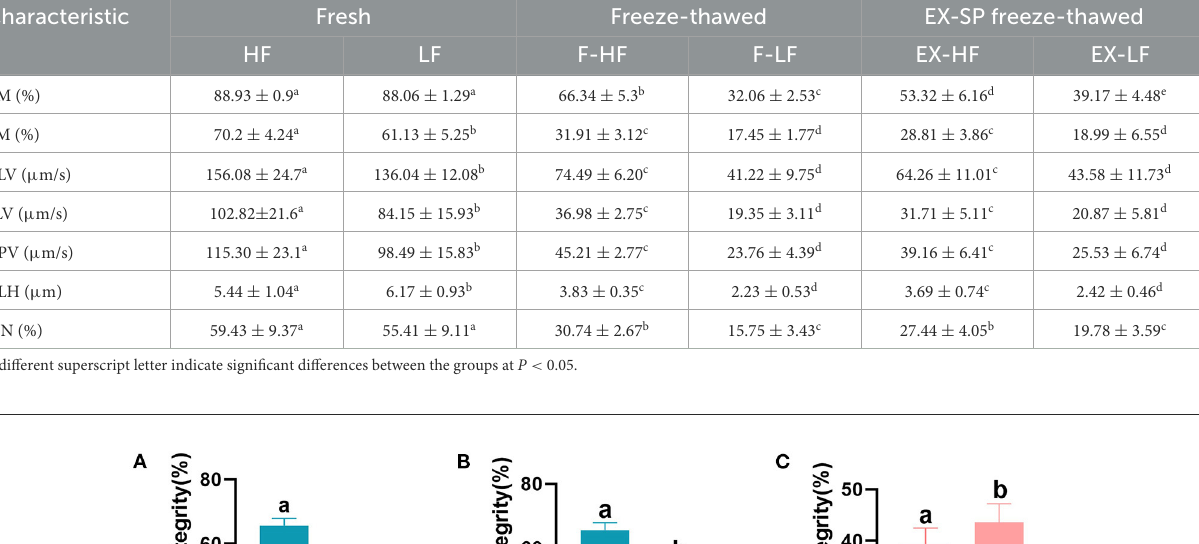
TABLE 1 Differences in the motion kinematics of spermatozoa with high and low cryotolerance among fresh ejaculates, freeze-thaw, and EX-SP freeze-thaw samples. Characteristic Fresh Freeze-thawed EX-SP freeze-thawed